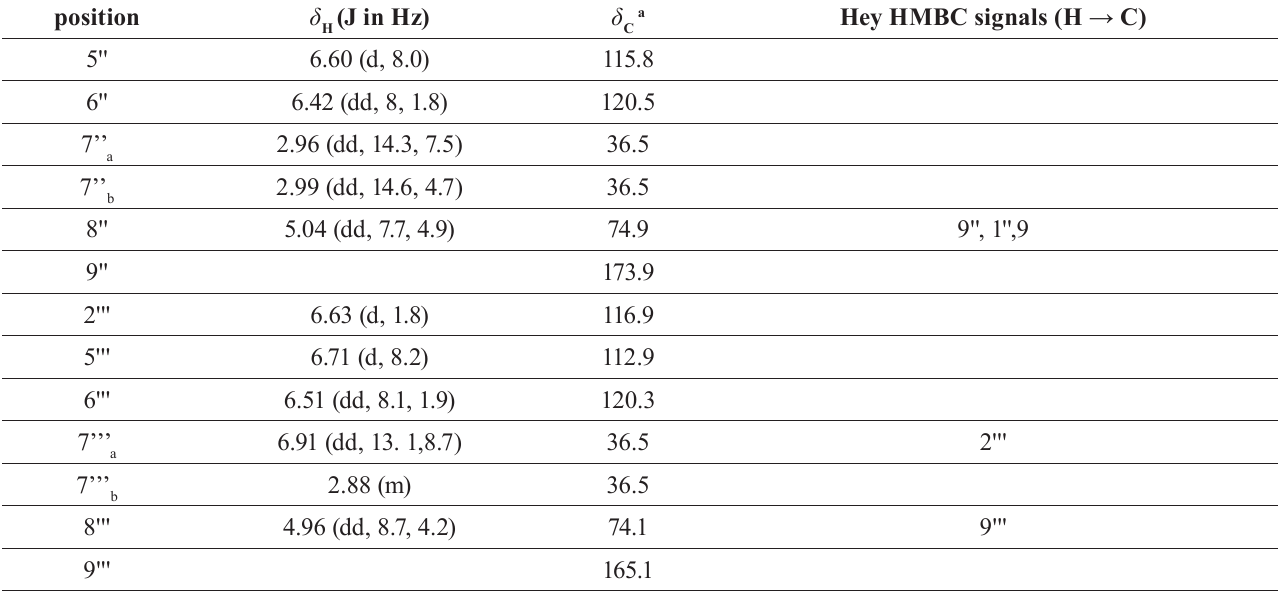
OD) of compound 16 (7’R, 8’ R, 8’’R, 8’’’R)-epi- salvianolic acid B). 3